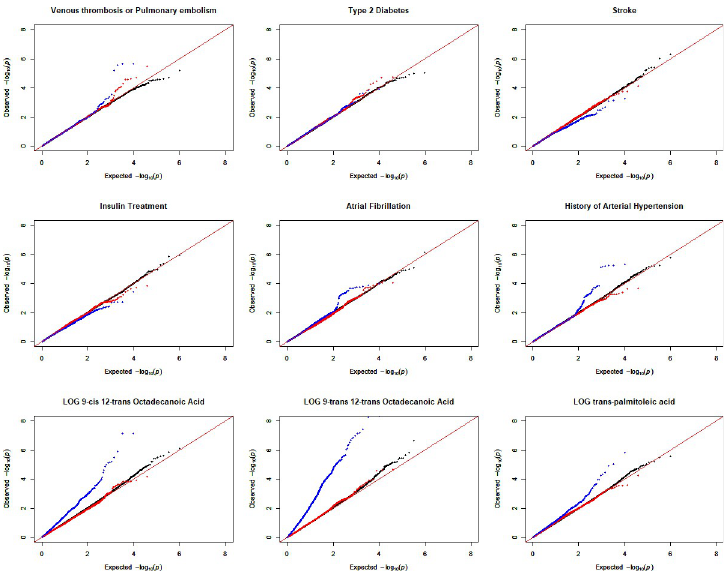
Fig 2. Quantile-quantile (Q-Q) plots of observed LRT p-values and referential G × Gs using two filtering methods. G × G based on 1000 random selected SNPs was performed as a baseline to assess the inflation (Black). G × G under main effect filtering (Blue) and G × G under Biofilter filtering (Red) were performed and compared with the G × G based on 1000 random selected SNPs for each phenotype. Individual Q-Q plots were generated to visualize the observed LRT p-values to the expected LRT p-values for cardiac traits and fatty acids. The red line represents the ideal estimation of LRT p-values. The corresponding genomic inflation factors were calculated for showing the model inflation (S3 Table).